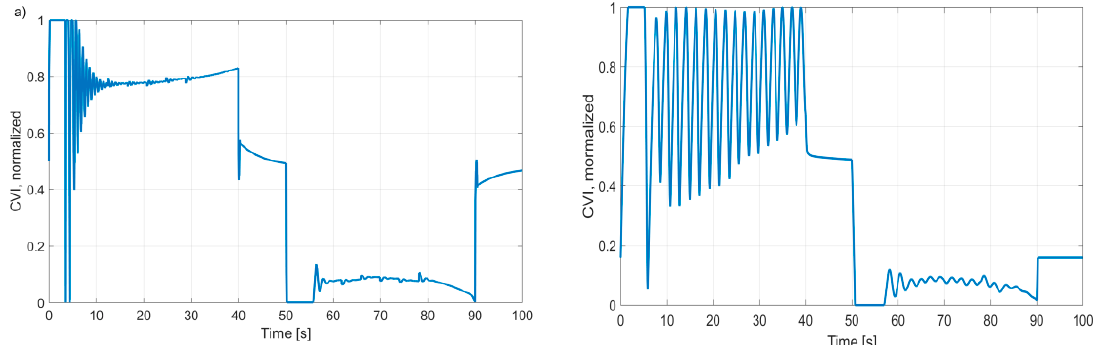
Figure 15. ( a ) Output of fuzzy logic FPD controller and ( b ) output of neural network NN controller.